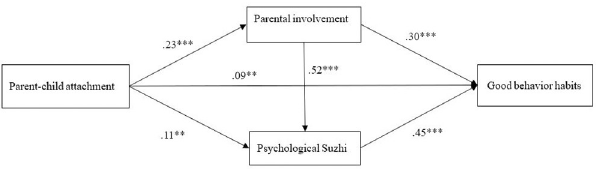
Fig 2. Model of the hypothesized mediator role of parental involvement and psychological Suzhi in the relationship between parent-child attachment and good behavior habits. All the path coefficients were standardized. � p < .05; �� p < .01, ��� p < .001.